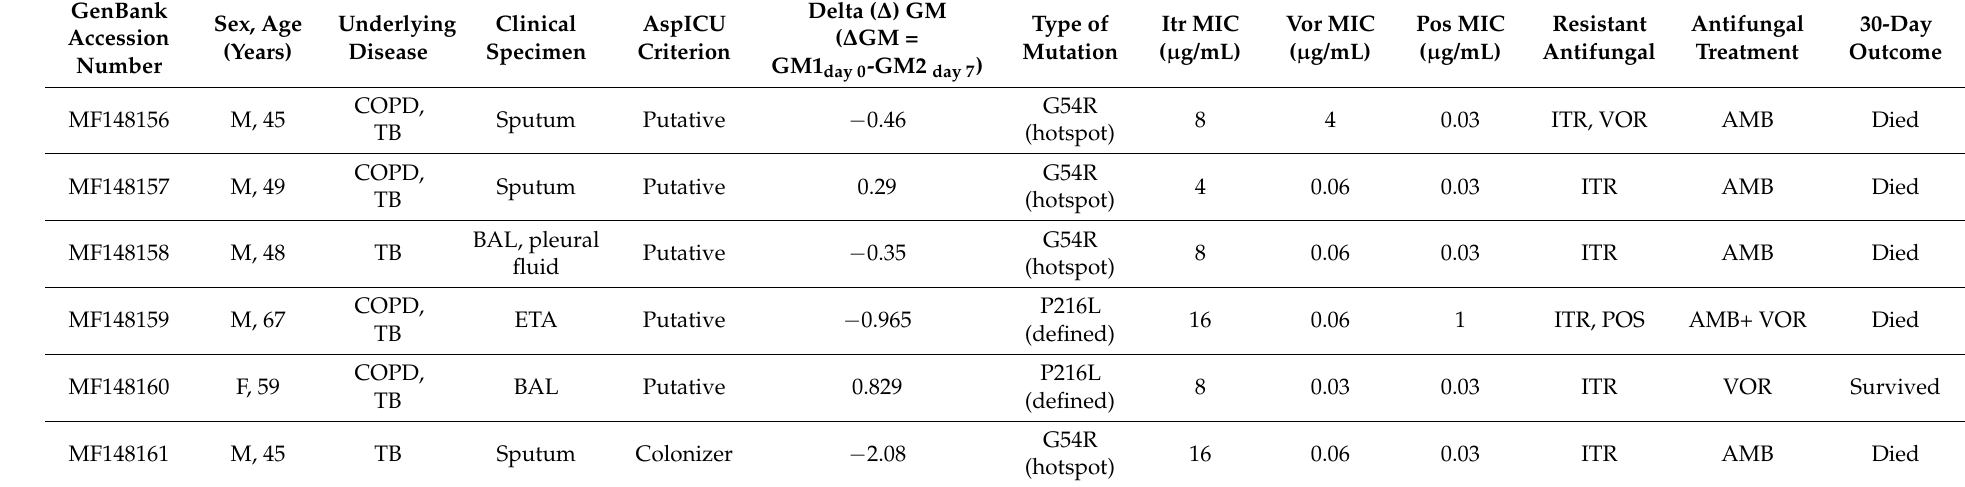
Table 7. Characteristics associated with mutations detected in azole-resistant Aspergillus fumigatus